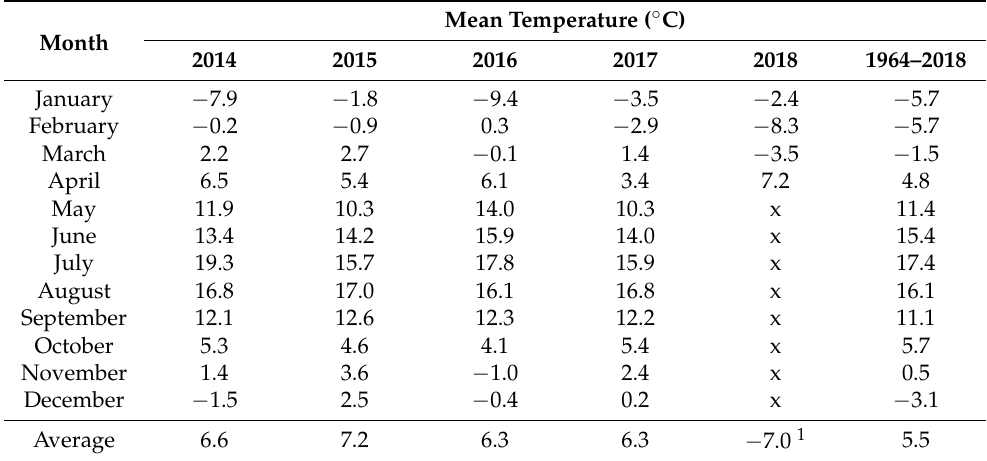
Table 2. Mean temperature ( ◦ C) in 2014–2018 compared to the long-term average (1964–2018) data *. Mean Temperature ( ◦ Month